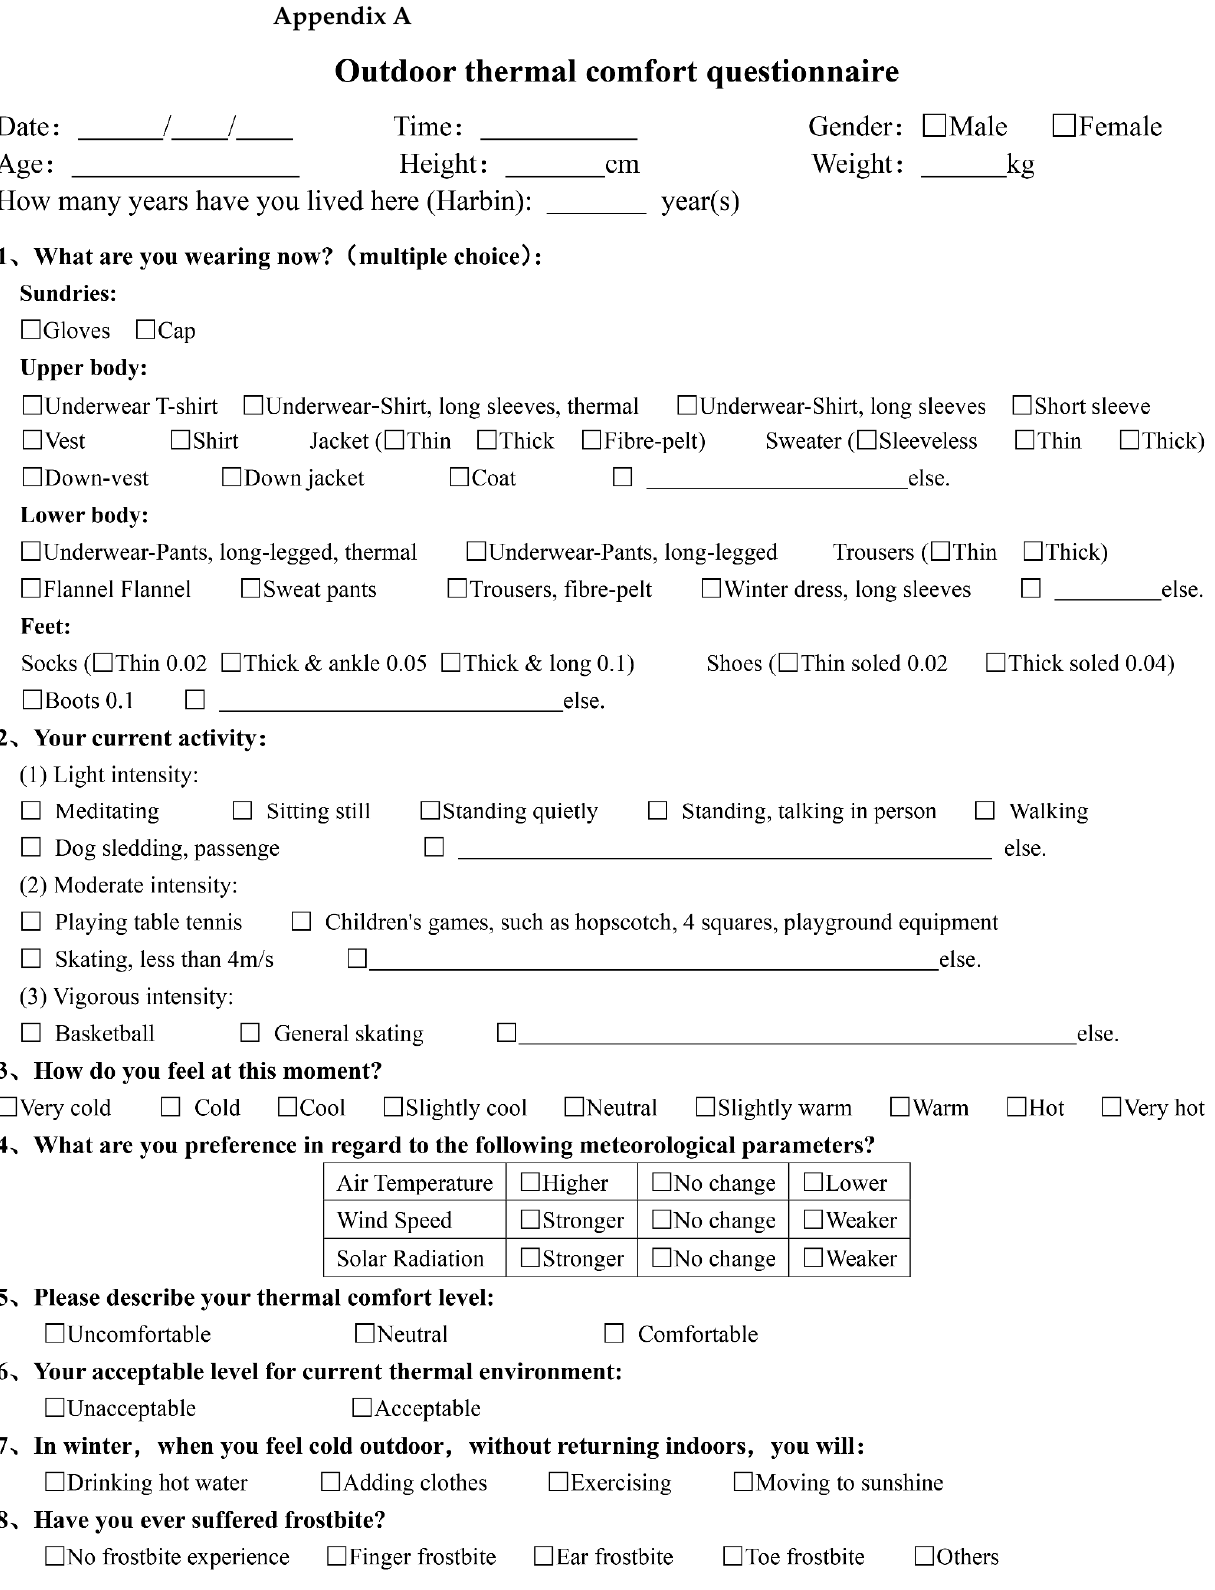
Figure A1. Outdoor thermal comfort questionnaire.